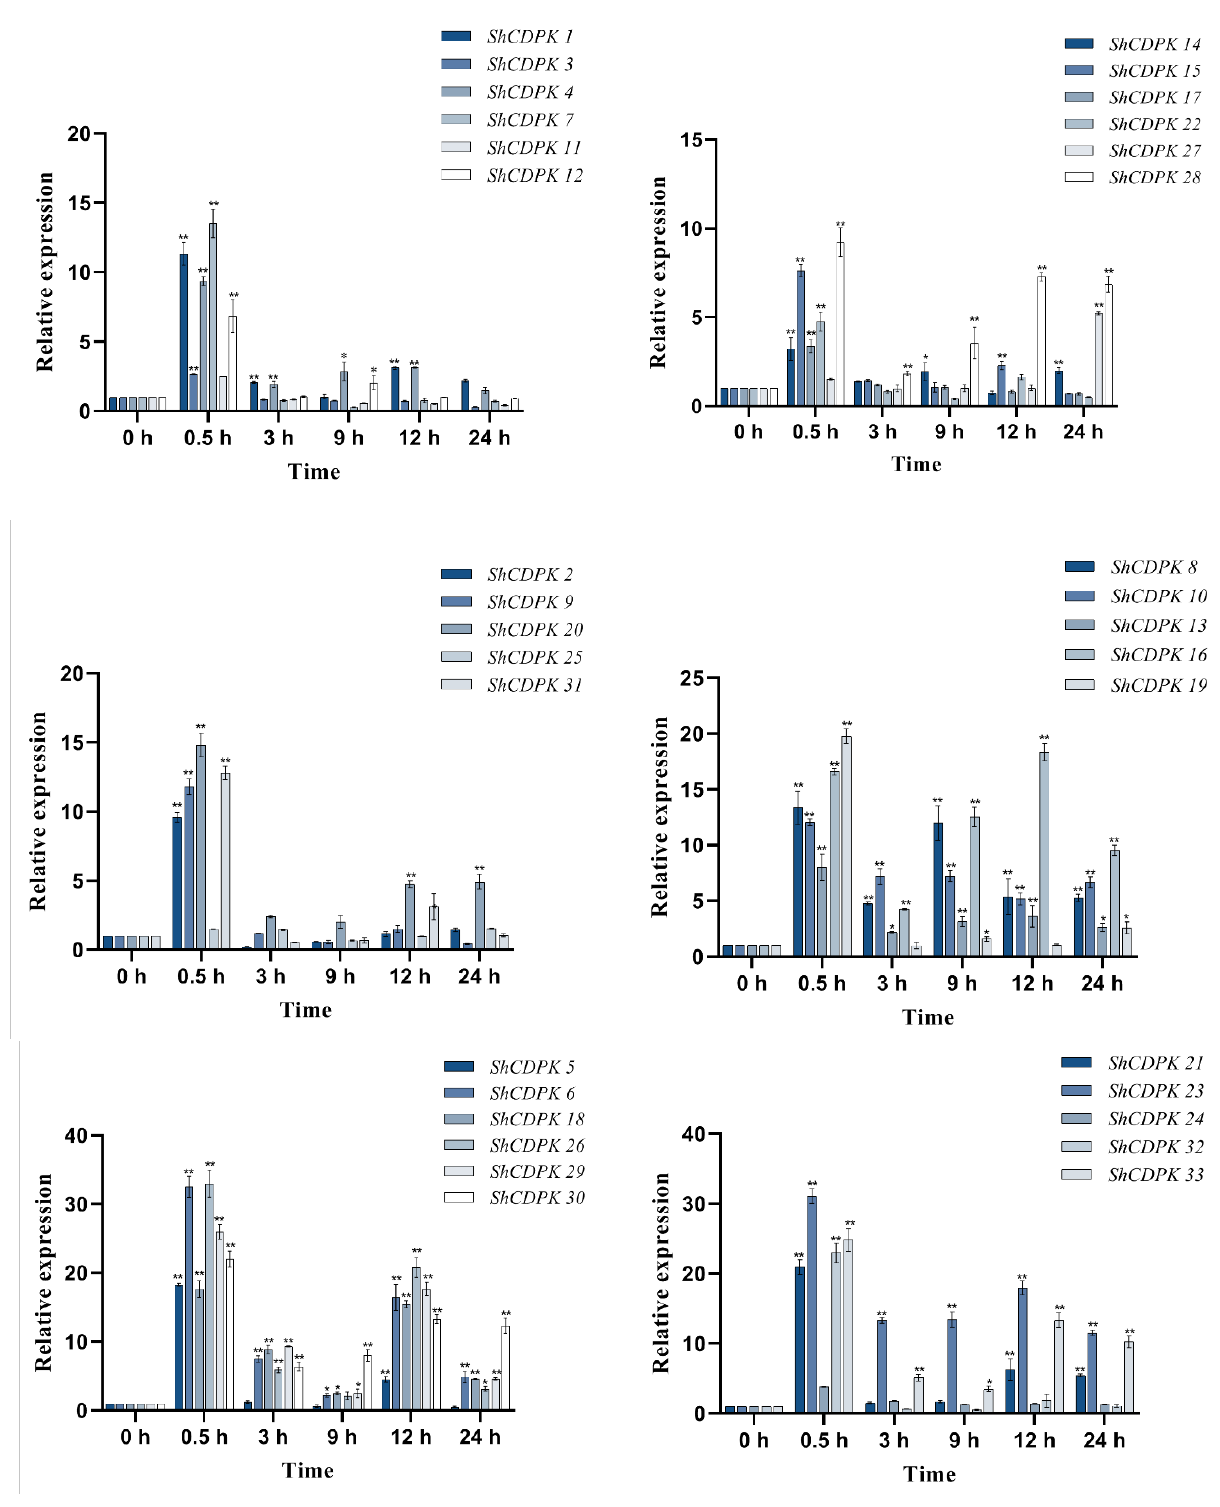
Figure 5. Expression analysis of CDPKs gene in Solanum habrochaites with real-time PCR under drought stress. Quantitative PCR data are represented as mean ± SEM. ** p < 0.01, * p < 0.05. All date represent mean values for three independent biological replicates.